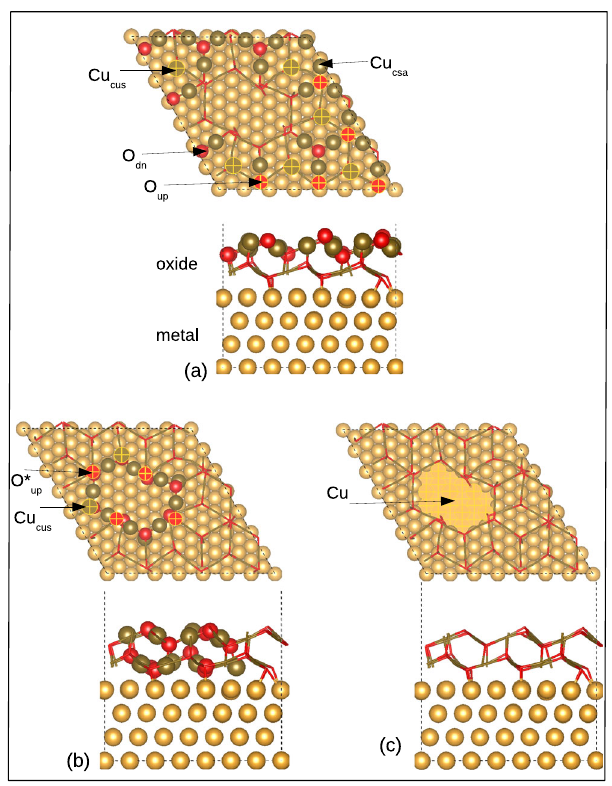
Fig. 2 Reactive sites on the partially oxide-covered copper surface. a Oxide surface, b oxide edges and oxide-wall surface, and c metal surface.